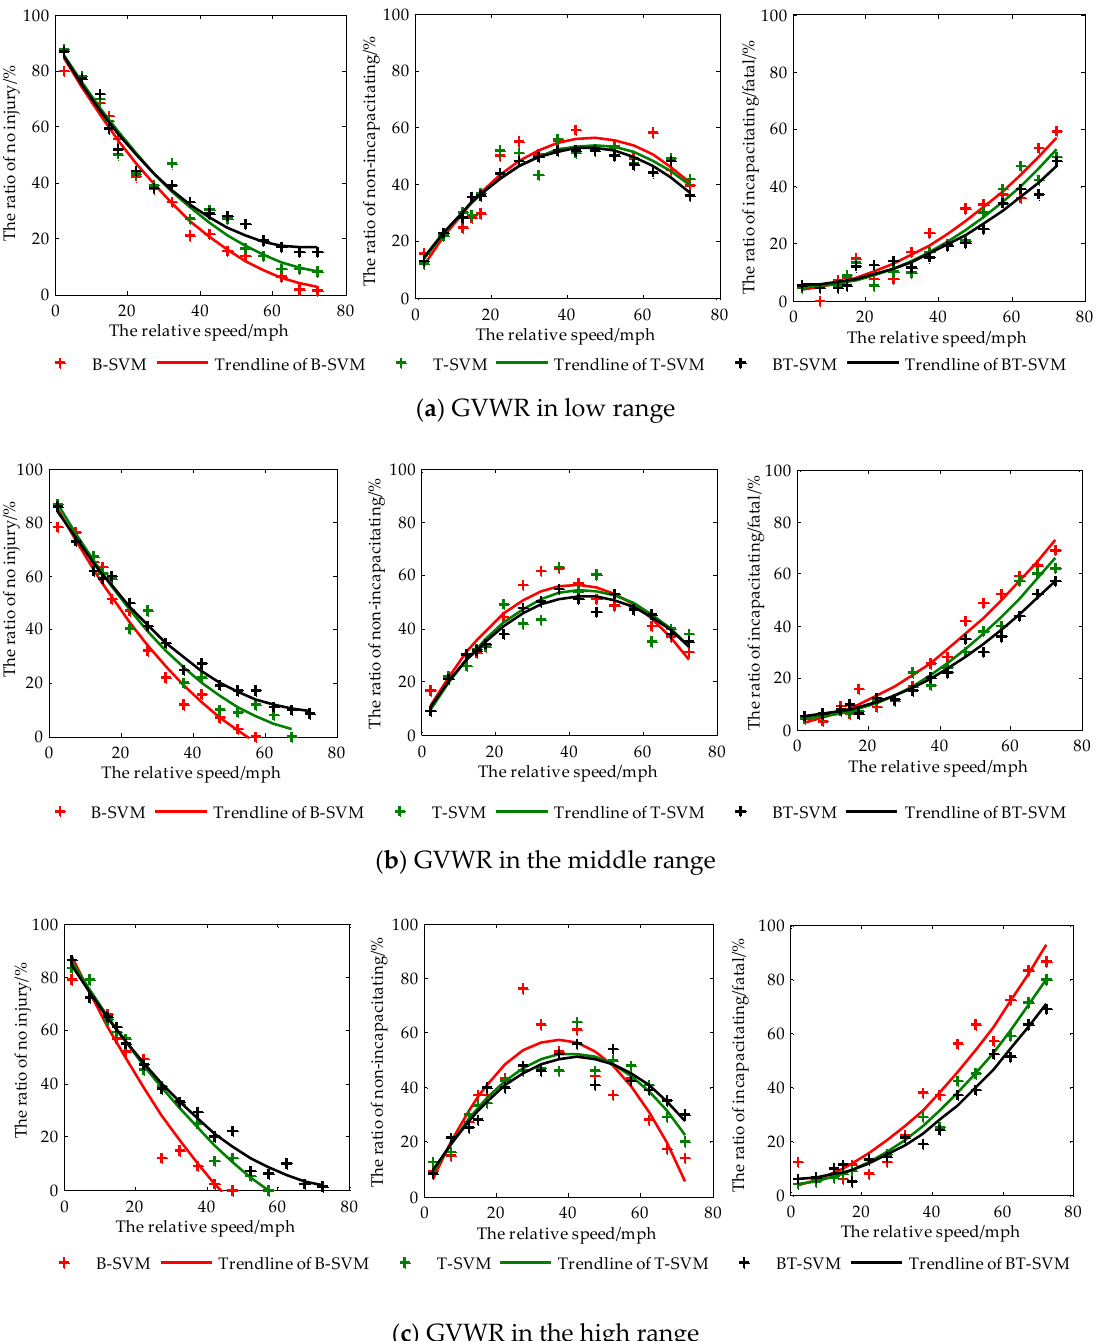
Figure 10. The changing trend of crash injury severity ratio with different SVMs. ( a ) When GVWR is in the low range, the changing trend of each crash injury severity ratio with the REL_SPEED in different SVM models. ( b ) When GVWR is in the middle range, the changing trend of each crash injury severity ratio with the REL_SPEED in different SVM models. ( c ) When GVWR is in the high range, the changing trend of each crash injury severity ratio with the REL_SPEED in different SVM